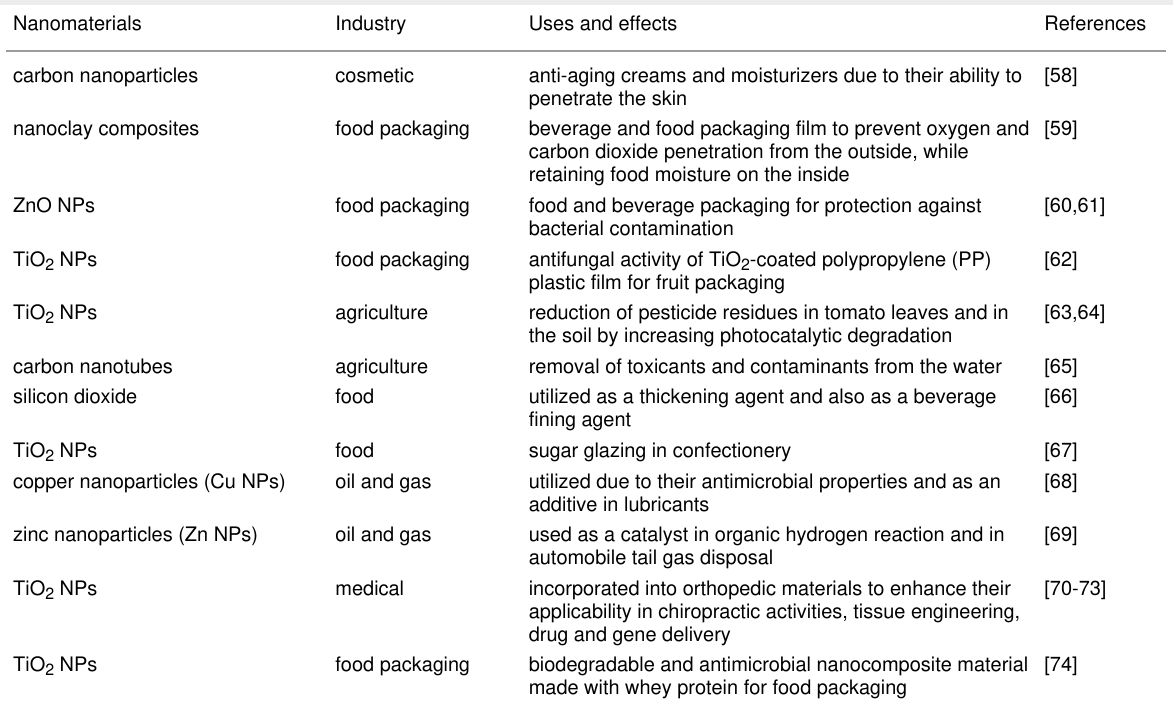
Table 1: Selected nanomaterials and their use in different